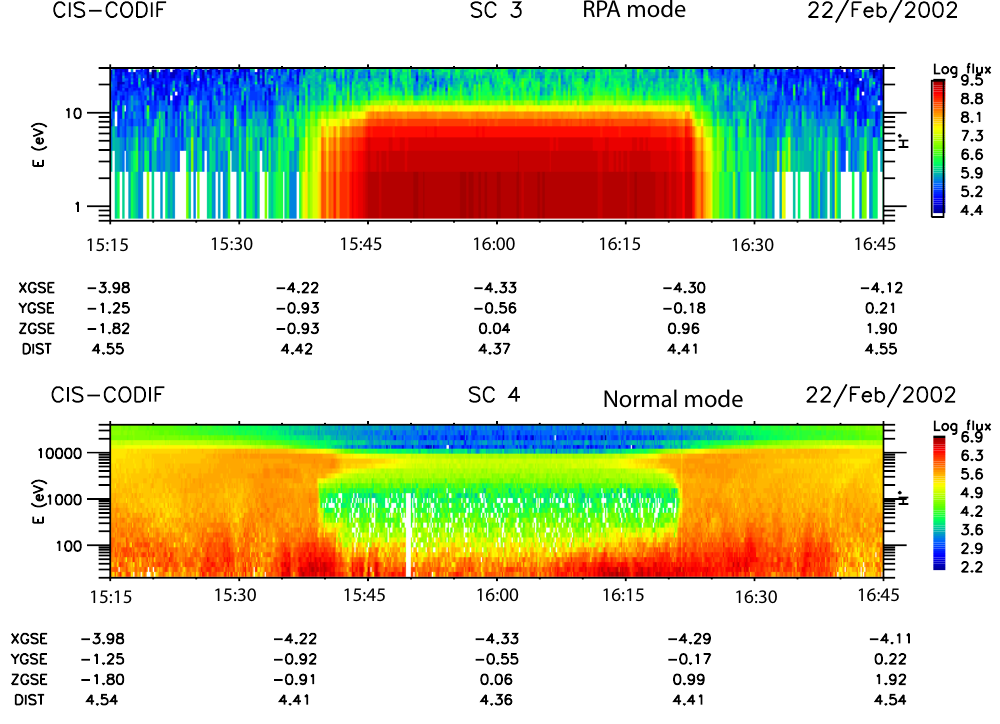
Fig. 13. SC3 and SC 4 CIS/CODIF proton spectrograms in flux units for the 22 February 2002 event. SC 3 and SC 4 GSE coordinates are indicated below each spectrogram. CODIF SC 3 is running in RPA mode (detection of particles with energy up to ∼ 30eV) whereas CODIF SC 4 is running in normal mode (detection of particles with energy from ∼ 25eV up to ∼